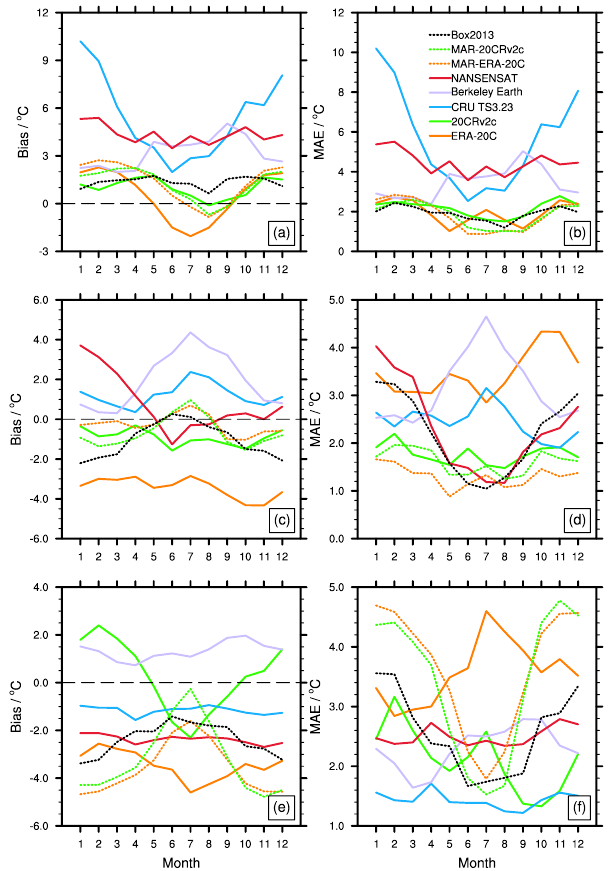
Figure 3. Mean over station-months of bias (a, c, e) and absolute error (b, d, f) relative to monthly mean SAT at: ice sheet stations above 1500m (a, b) ; ice sheet stations below 1500m (c, d) ; and coastal (DMI) stations (e, f) . Ice sheet stations are from GC–Net, PROMICE and K-transect. All available station months from 1979 onwards are used. All datasets included in this figure are elevation corrected: several shorter reanalyses, AIRS, and MAR–ERA. Note that the vertical scales vary with panels.